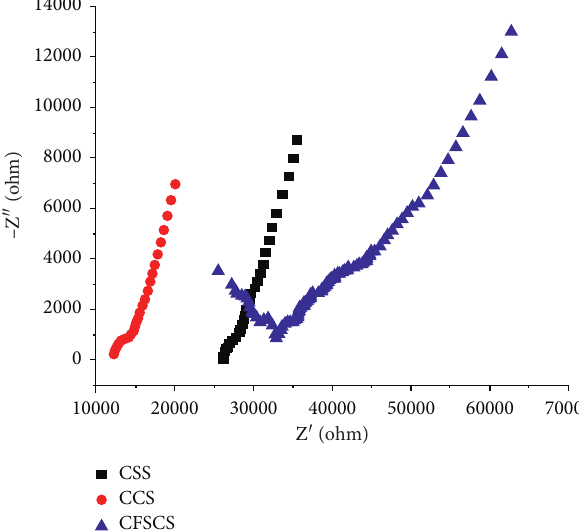
Figure 5: Impedance spectra of mortar samples at 180d. CSS: standard mortar; CCS: coral mortar; CFSCS: coral mortar with 15% fly ash and 15%